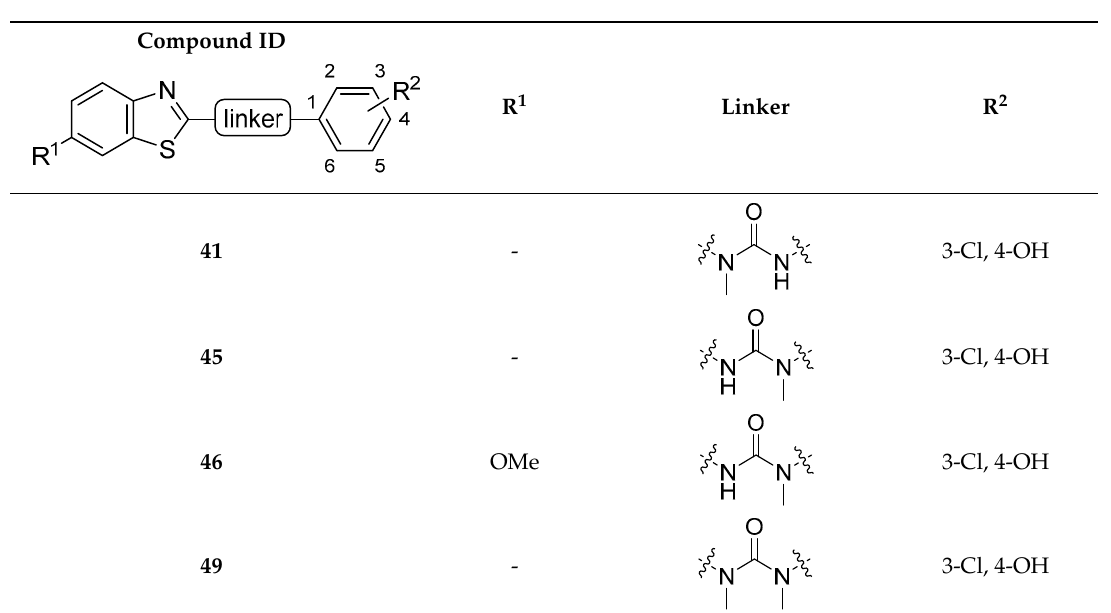
Table 2. Second series of prepared compounds ( 23–49 Table 2. Cont.